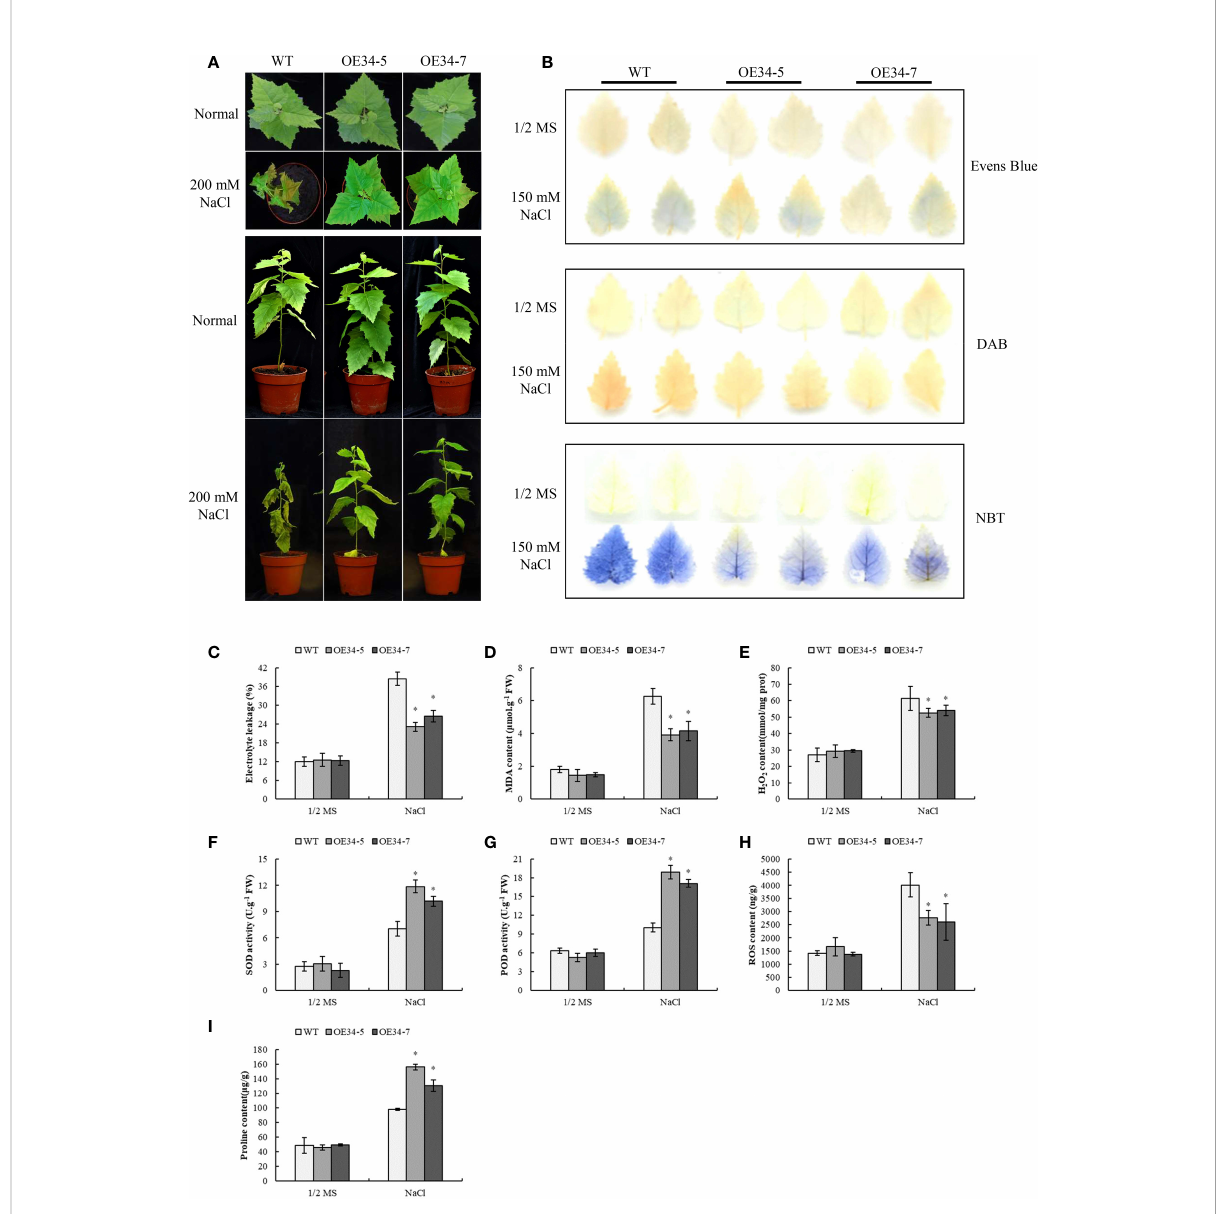
FIGURE 8 Phenotype analysis, biological staining and physiological determinations of two stable transgenic lines of BpGRAS34 and WT plants. (A) Phenotype of OE34-5 , OE34-7 and WT plants treated with 200 mM NaCl. (B) OE34-5 , OE34-7 and WT plants treated with 150 mM NaCl and stained with Evens blue, DAB and NBT to visualize cell death, H 2 O 2 and O − · 2 accumulation. (C – I) Electrolyte leakage rates (C) , MDA content (D) , H 2 O 2 content (E) , SOD and POD activity (F, G) , ROS content (H) and proline content (I) of OE34-5 , OE34-7 and WT plants treated with 150 mM NaCl. WT: wild-type birch plants; OE34-5 and OE34-7 : two stable transgenic lines of BpGRAS34 overexpression. * signi fi cant (P< 0.05) difference was observed compared with WT plants. Three independent experiments were performed in physiological determinations, and data are means ± SD from the three